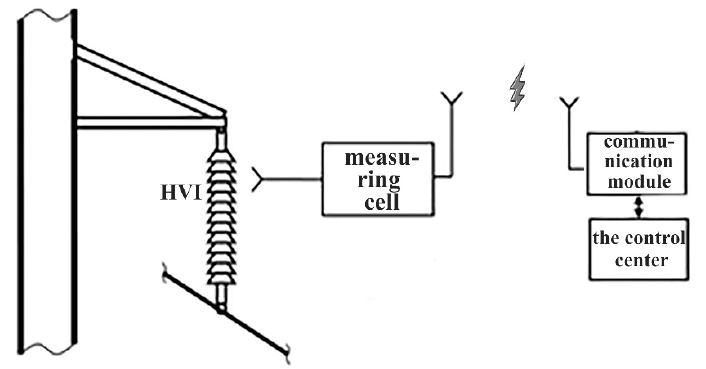
Figure 6. Flowchart of the measuring